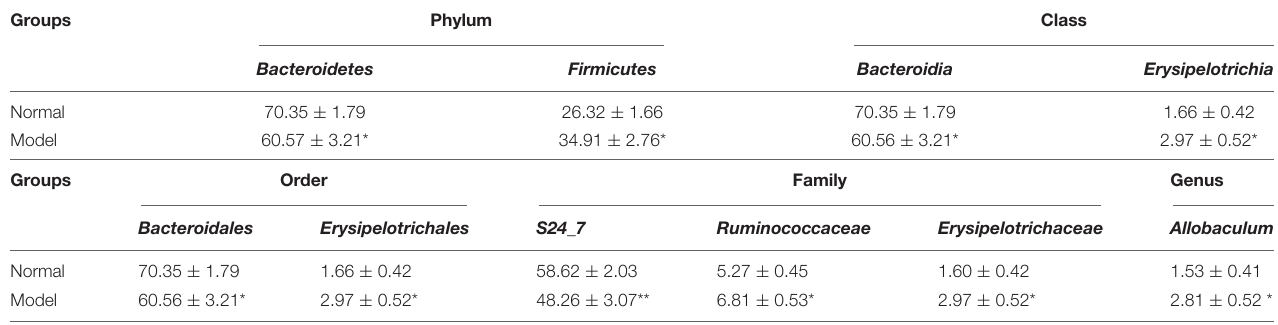
TABLE 2 | Relative abundance of phylum, class, order, family, genus > 1% in normal and PD model mice a .